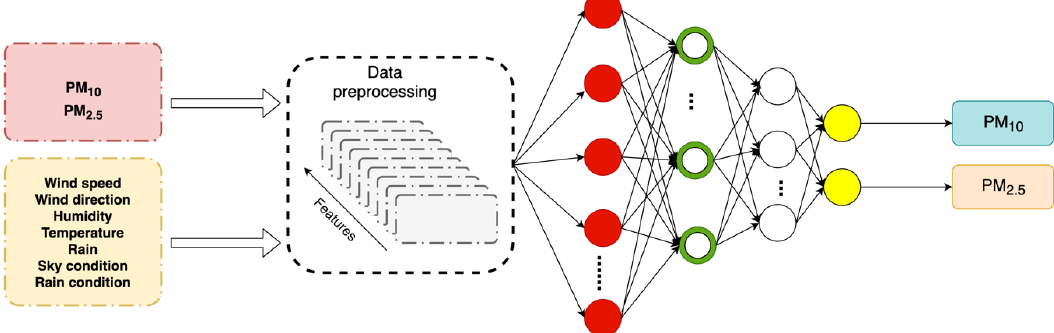
Figure 6. The layer structure of the convolutional neural network–long short-term (CNN–LSTM) model.